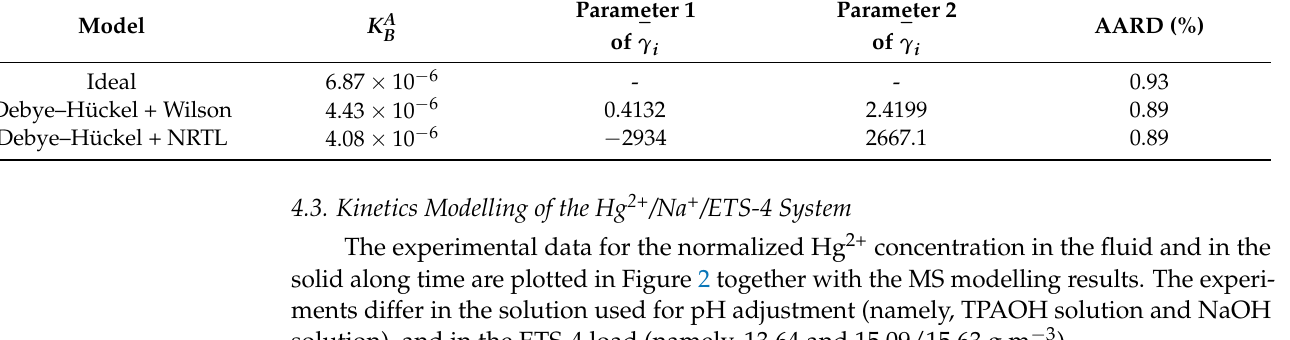
Table 2. Equilibrium parameters obtained for the Hg 2+ /Na + /ETS-4 system. The range of ionic strength ( I ) in the liquid solution is (6.74 − 6.83) × 10 (cid:2879)(cid:2872) molal.